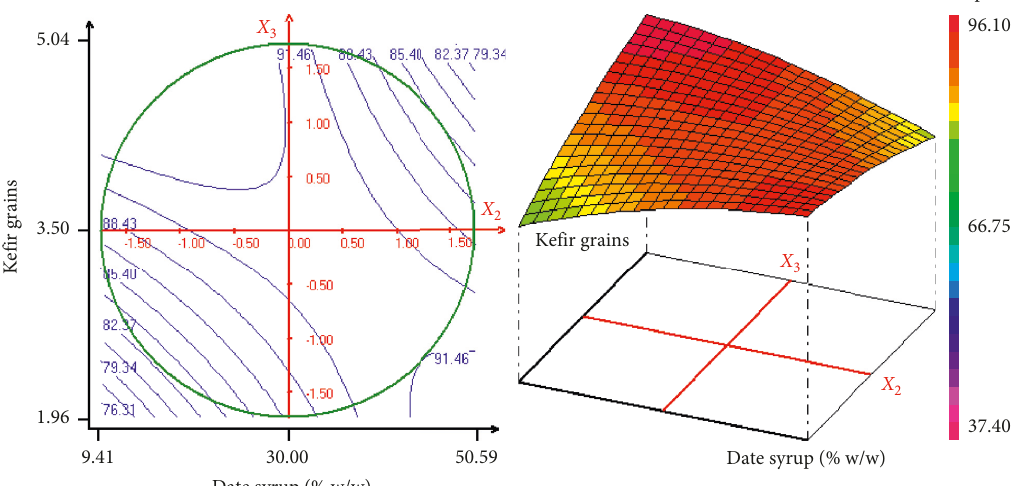
Figure 3: Response surface and contour plots that represent the effect of kefir grains and date syrup on % DPPH scavenging